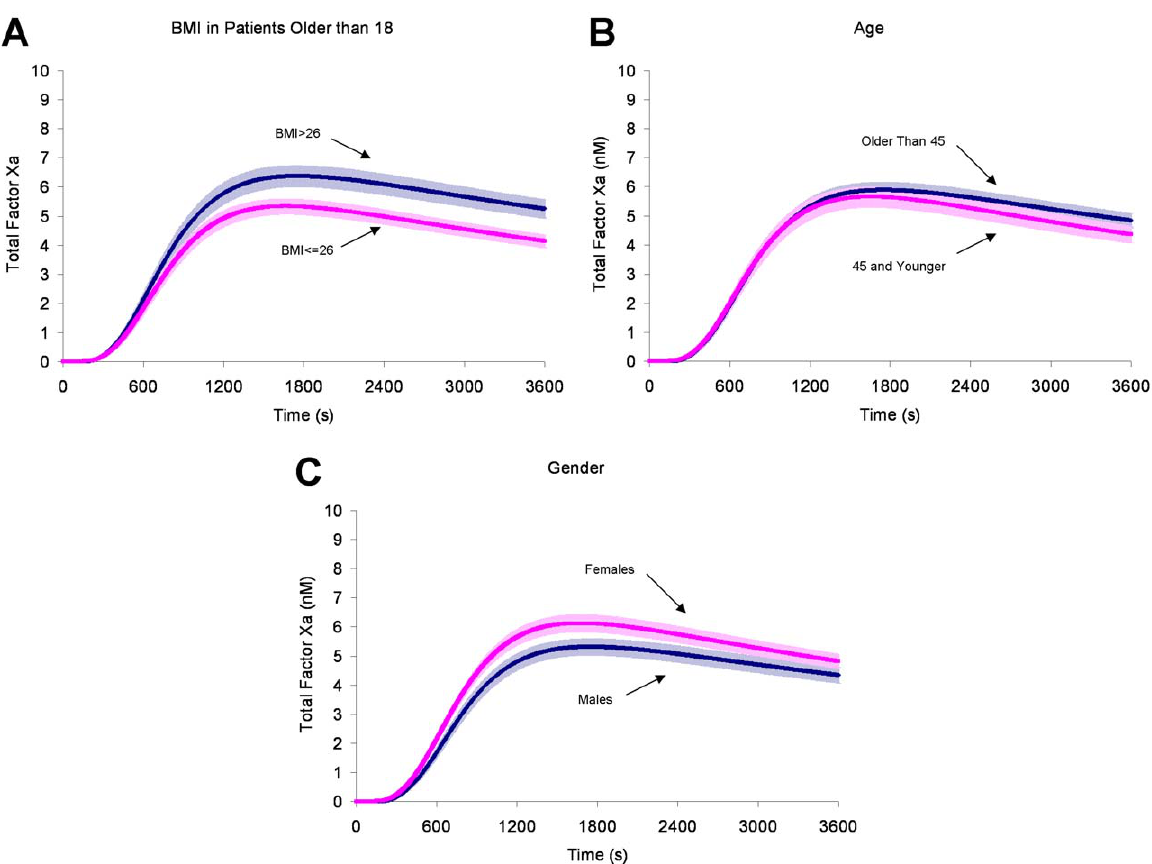
Figure 3. Factor Xa generation segregated by potential risk factors. Individuals within the healthy control population were separated into categories to evaluate the response of fXa generation between groups. The groups were: Panel A ) Body Mass Index (BMI); # 26 kg/m 2 (n=264) and . 26 kg/m 2 (n=193); Panel B ) Sex; men (n=201) and women (n=272); Panel C ) Age; # 45 yrs (n=223) and . 45 yrs (n=250). All fXa profiles are shown as the mean and the 95%